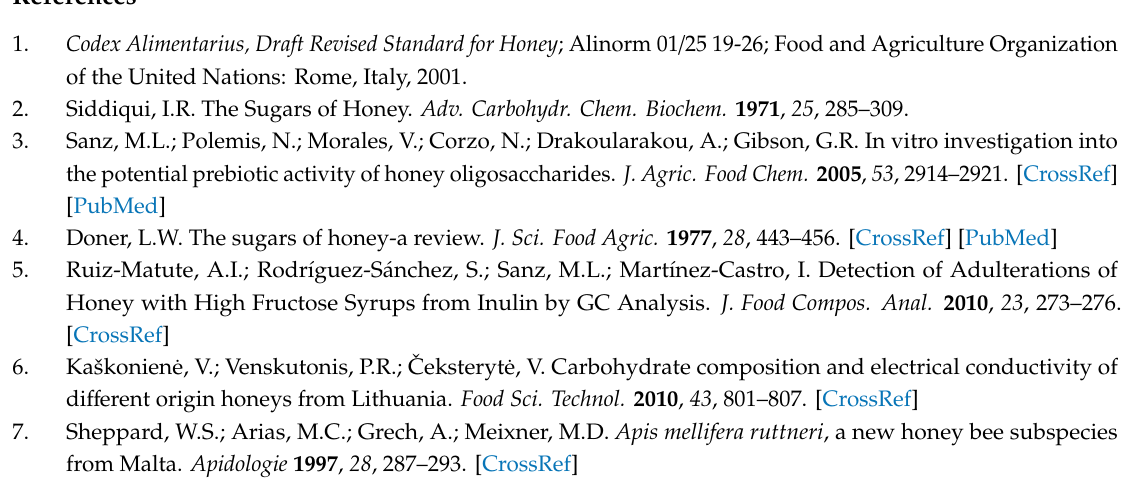
Figure S1: Map of Maltese islands highlight locality of honey samples in Table S1, Figure S2: Two component plot from PCA on Median filtered data in the region between 760 and 1400 cm − 1 , Figure S3: Loading plot for the first two component of PCA on Median filtered data in the region between 760 and 1400 cm − 1 , Table S1: Sample code, locality and date of harvest for local